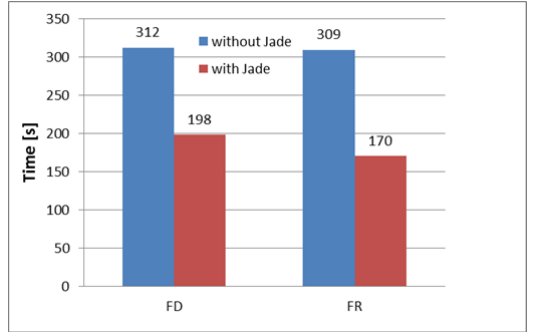
Figure 11: Execution time of FaceDetection and